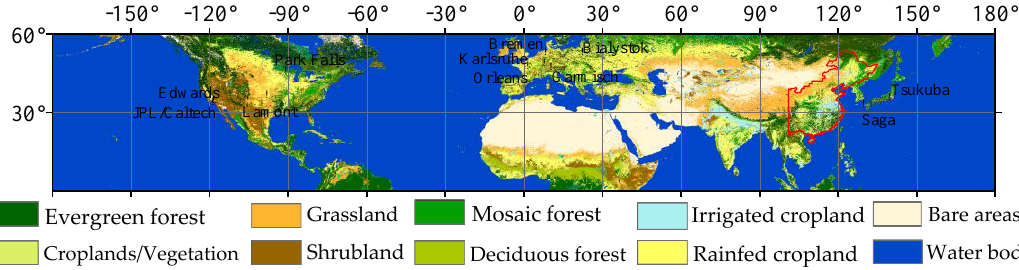
Figure 1. Global land-cover data in 2015 from 0 to 60°N obtained from the European Space Agency. Global greening and XCO 2 trends are evaluated in Eastern China, shown with red edge for this case study. The names of Total Carbon Column Observing Network (TCCON) measurement sites are labeled (Section 2.4.2).